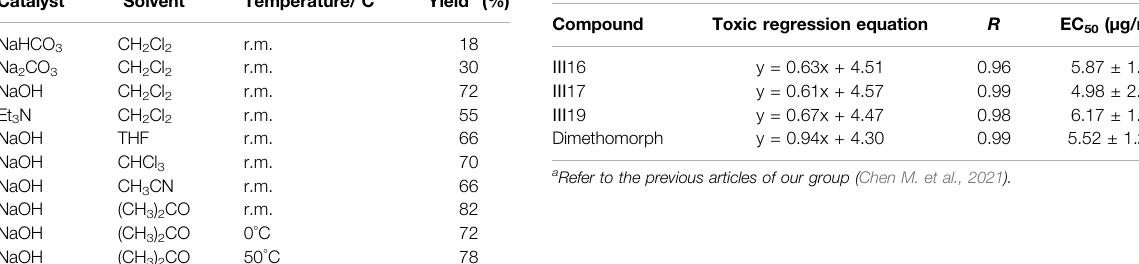
TABLE 3 | EC 50 value of antifungal activity for part of compounds against P.